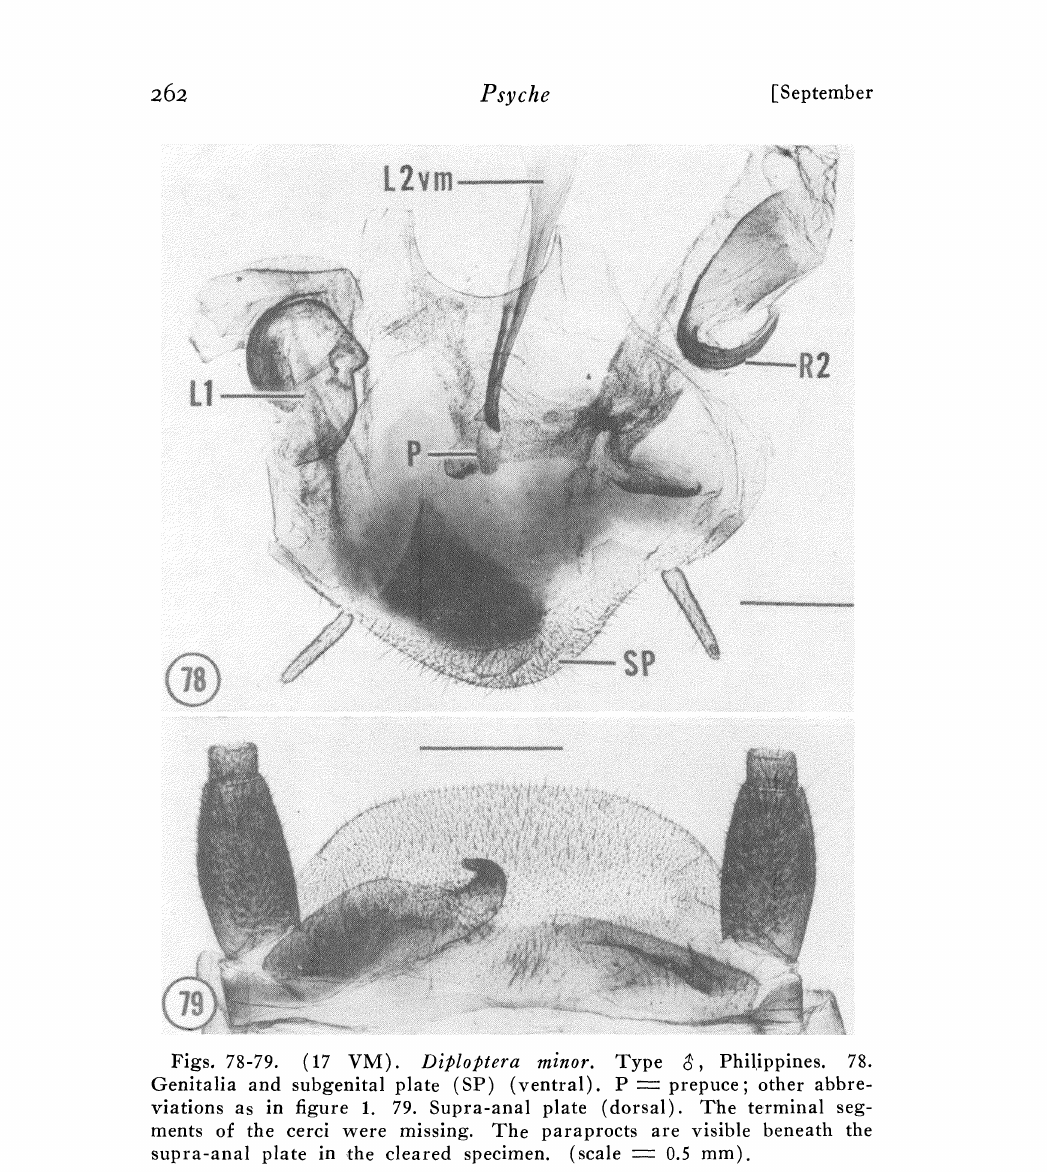
, Phil.ippines. 78.